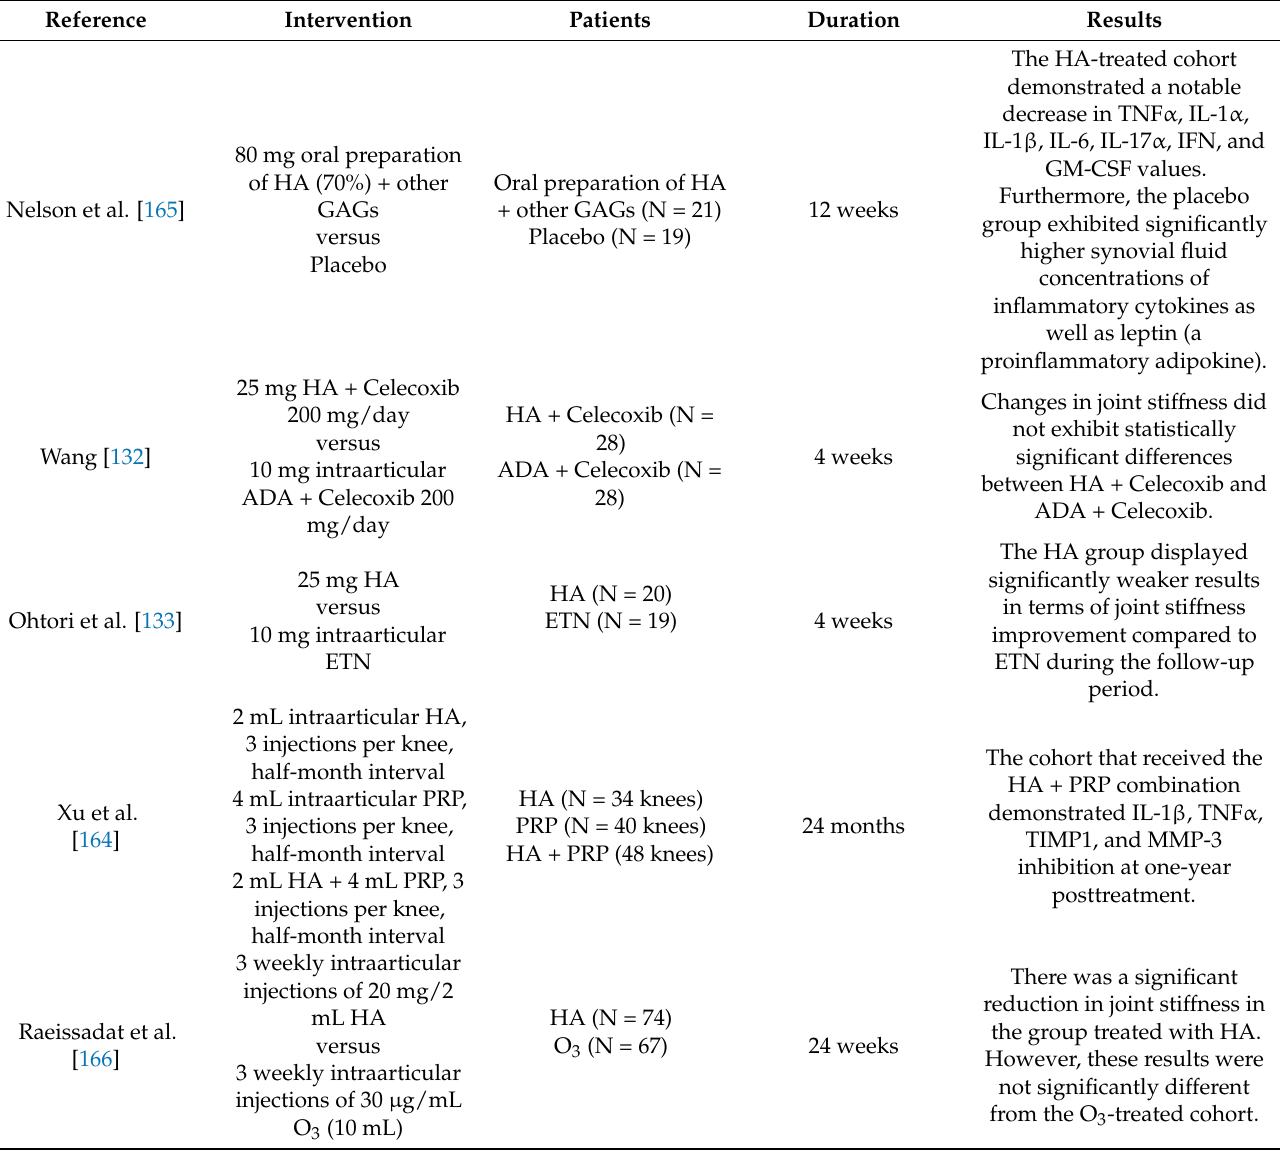
Table 3. Hyaluronic acid (HA) treatment in knee OA: anti-inflammatory